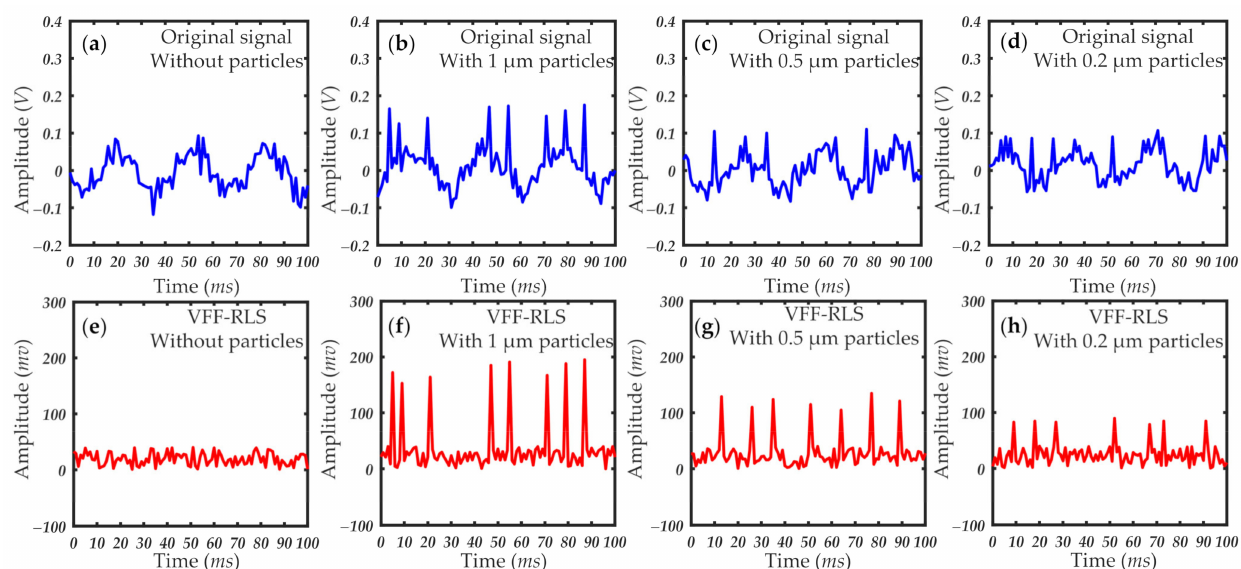
Figure 6. Original detection signal and VFF-RLS filtered signal with and without